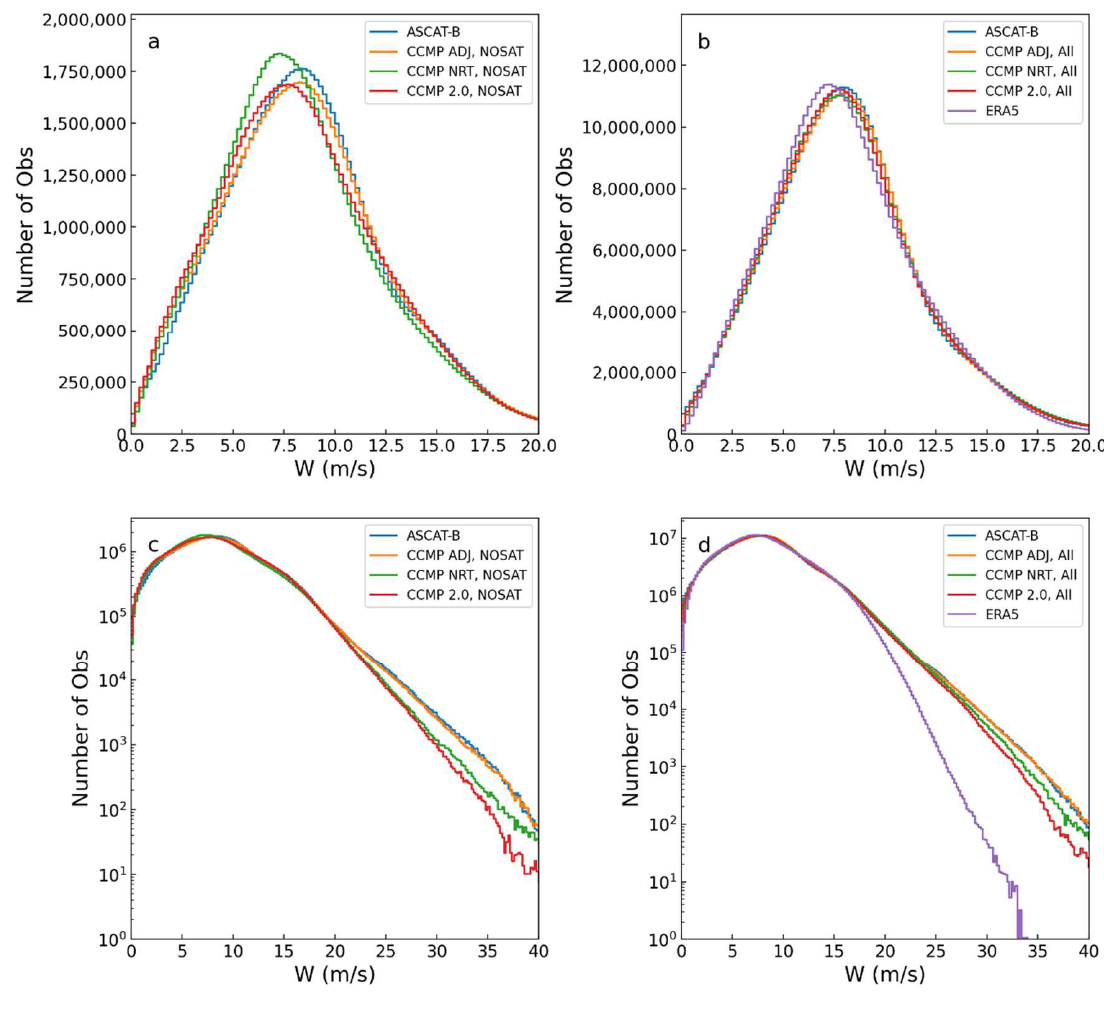
Figure 14. Histograms of wind speed for ASCAT-B, three version of CCMP and ERA5. Panels ( a ) and ( c ) show the results for collocations without satellite observations in CCMP, and ( b , d ) show all colocations. Panels ( a – d ) are identical except for the vertical axis, which is displayed in logarithmic form in ( c , d ).